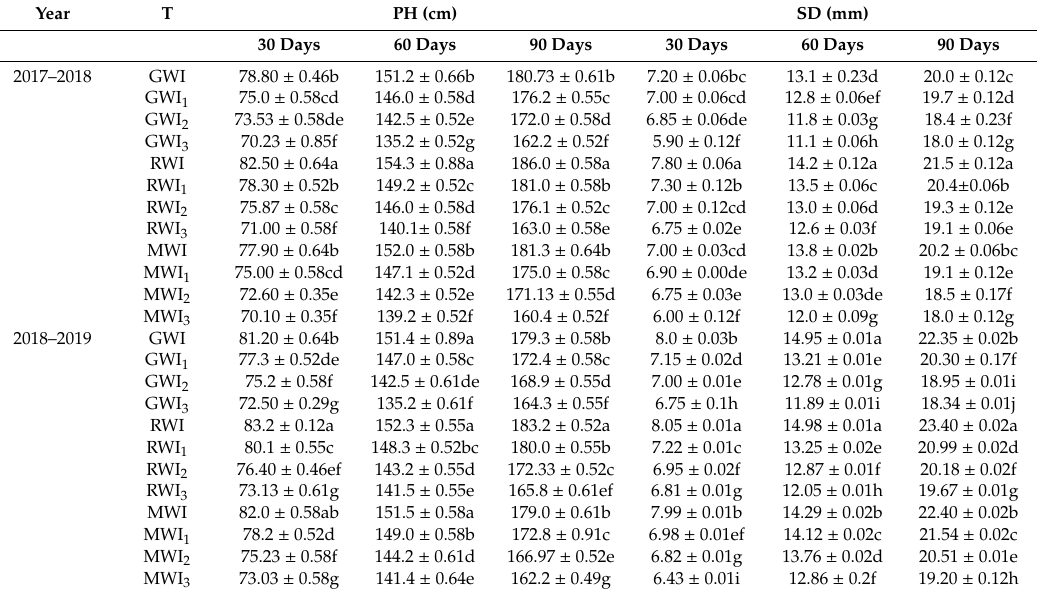
Table 4. Plant height and stem diameter at 30, 60 and 90 DAT for 12 experimental